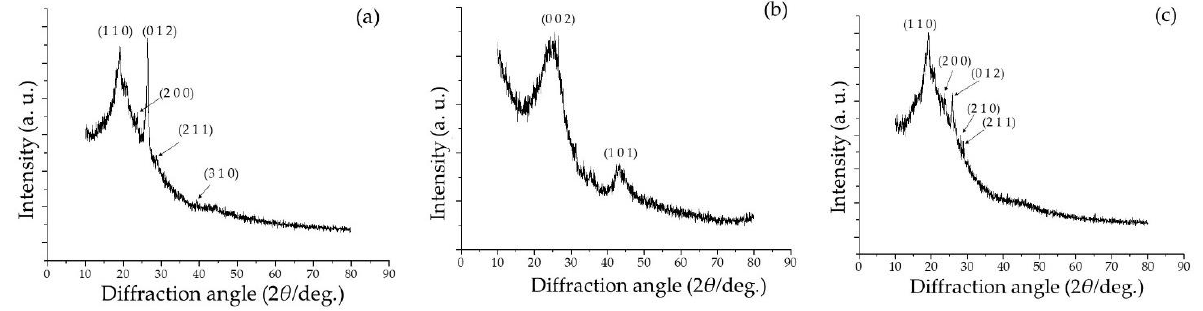
Figure 4. XRD spectra of ( a ) standalone semi-polycrystalline polyaniline (SPani), ( b ) activated carbon (AC), and ( c ) semi-polycrystalline polyaniline-AC (SPani-AC) composite.